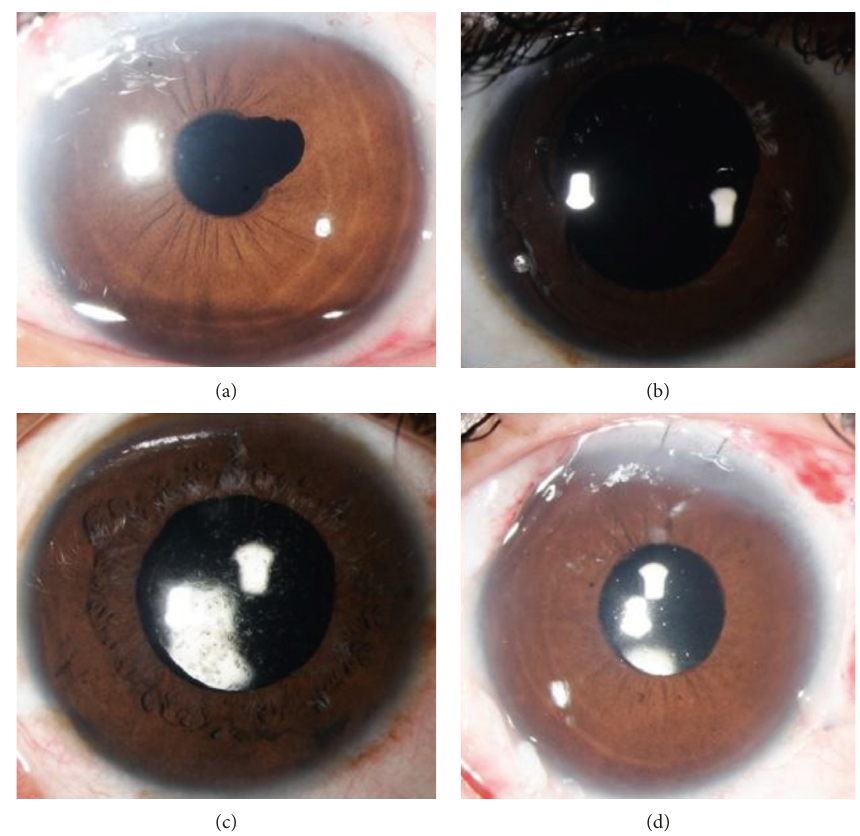
Figure 2: Postoperative images of patients after sutureless, glueless, flapless, intrascleral fixated intraocular